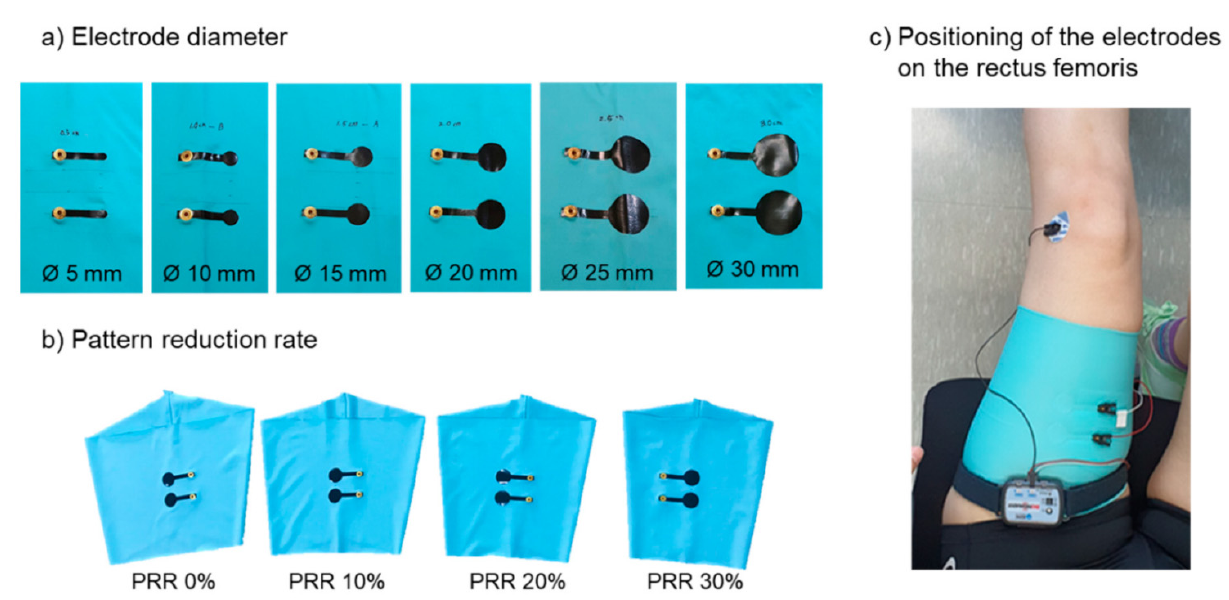
Figure 4. Electrode preparation in varied ( a ) electrode diameters and varied ( b ) pattern reduction rate (PRR). ( c ) positioning of the electroded on the rectus femoris. From Reference [79], originally published under a CC-BY license.